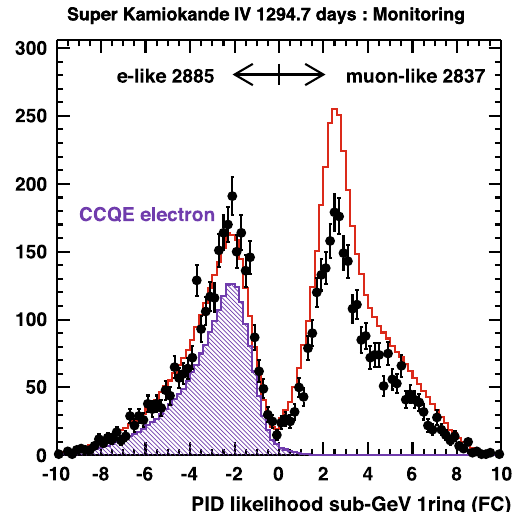
Fig. 3 The likelihood distribution of the sub-GeV events to separate μ -like events from e-like events. The red line shows the MC calculation normalized to the e-like events. The lightly painted region represents the MC CCQE electron events. The mis-identification is less than 1% for sub-GeV and ∼ 2% for